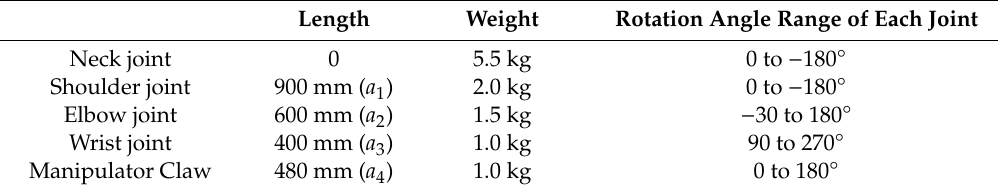
Table 1. The main parameters of the underwater